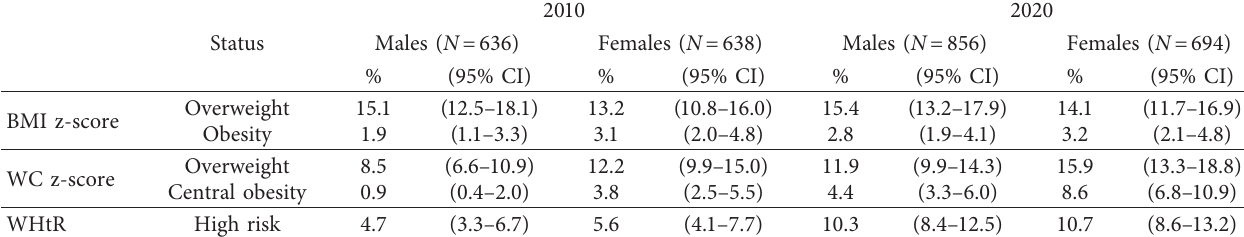
Table 3: Prevalence of BMI overweight/obesity, central overweight/obesity, and WHtR ≥ 0.5 over time.